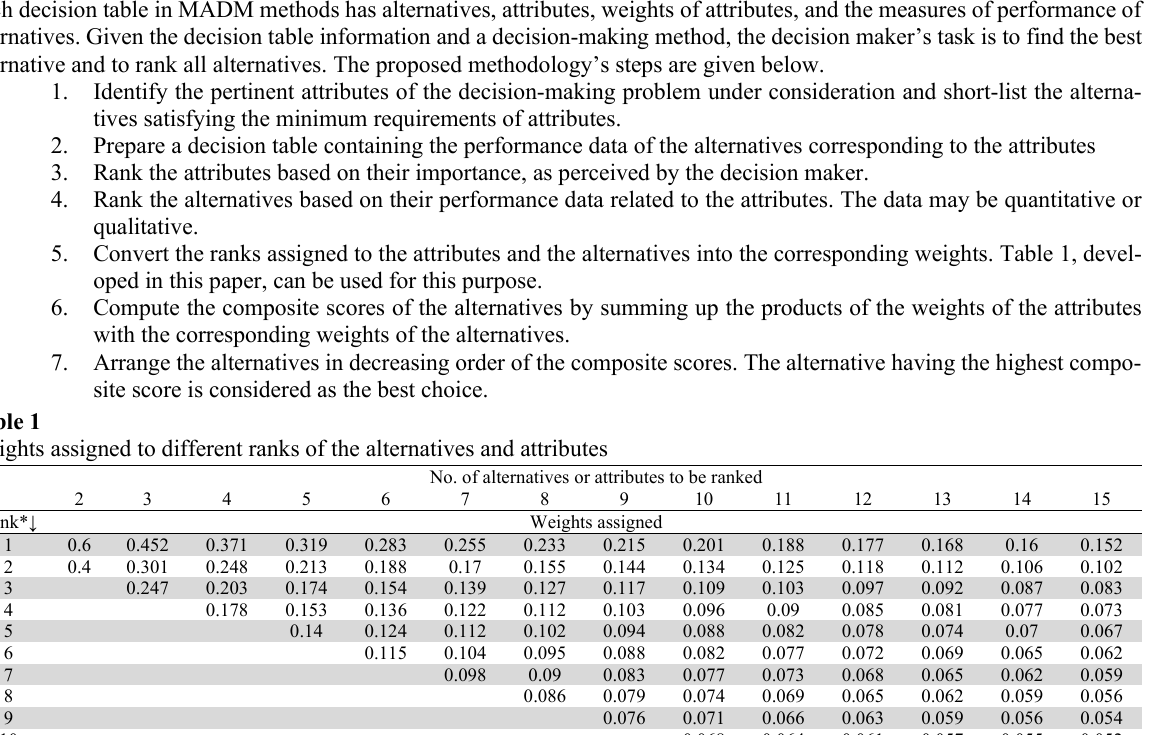
No. of alternatives or attributes to be ranked